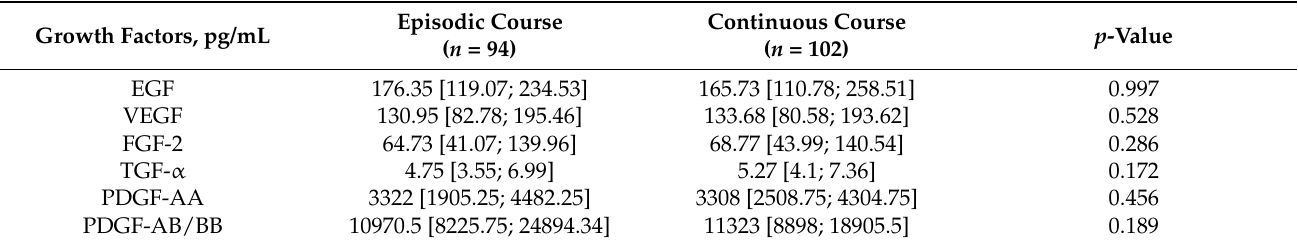
Table 6. Concentration of serum growth factors in patients with episodic or continuous clinical course of schizophrenia (Me [Q1;